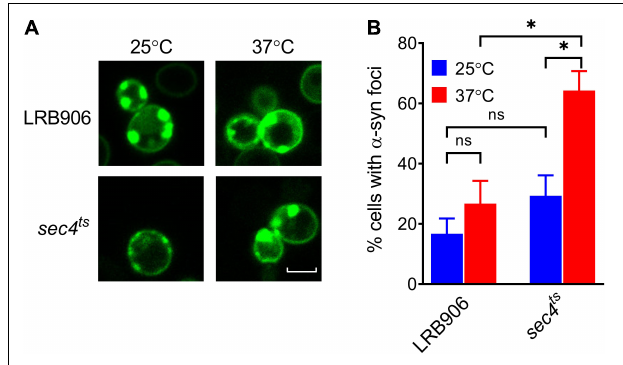
FIGURE 3 | α -Syn aggregation in LRB906 and sec4 ts cells. (A) Confocal images of LRB906 and sec4 ts cells expressing α -syn-yeGFP prior to (25 ◦ C) and following incubation at restrictive temperature of 37 ◦ C for 1 h 15 min. Scale bar corresponds to 5 µ m. (B) Bar graph showing percentage of cells containing α -syn foci (expressed as mean ± SD) under these experimental conditions. The percentage of cells with foci was determined by visual inspection of at least 300 cells. Results shown are representative of at least 3 independent experiments. The statistical significance was assessed using one-way ANOVA with Bonferroni posttest. ns (not significant) P > 0.05; * P ≤